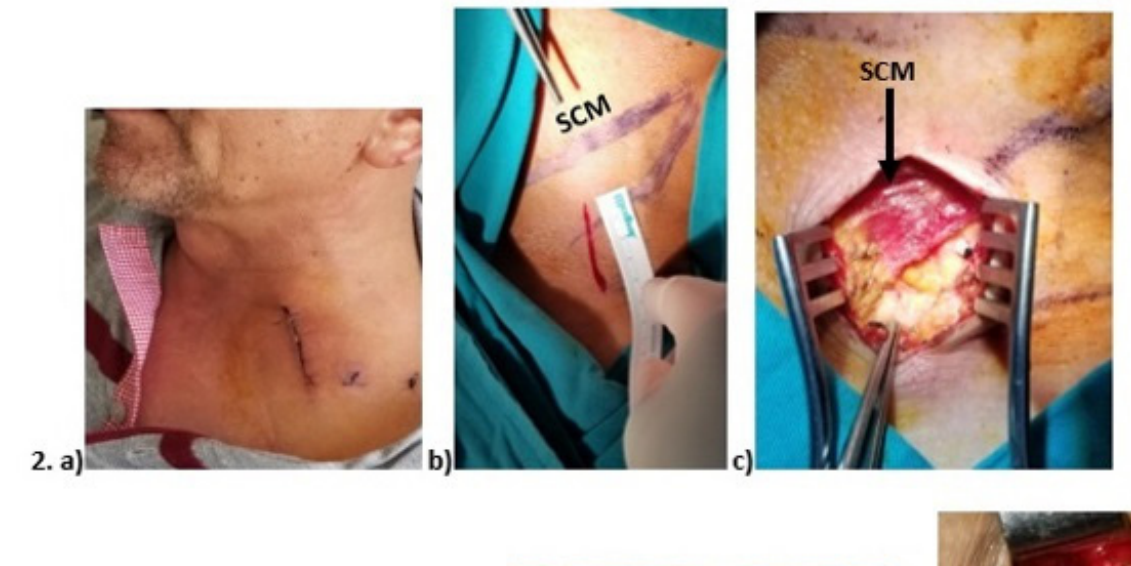
Table 1. Demographic